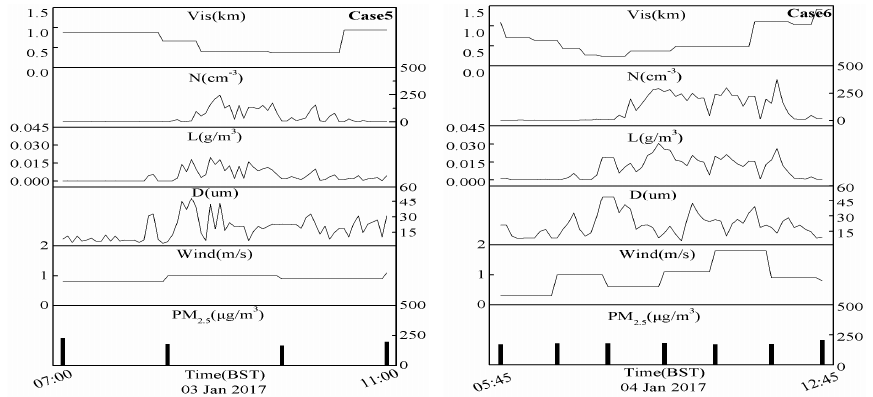
Figure 2. Temporal variations of 5-min averages of D, L, and N, and hourly averages of Vis, Wind speed and C PM2.5 for the six fog processes.